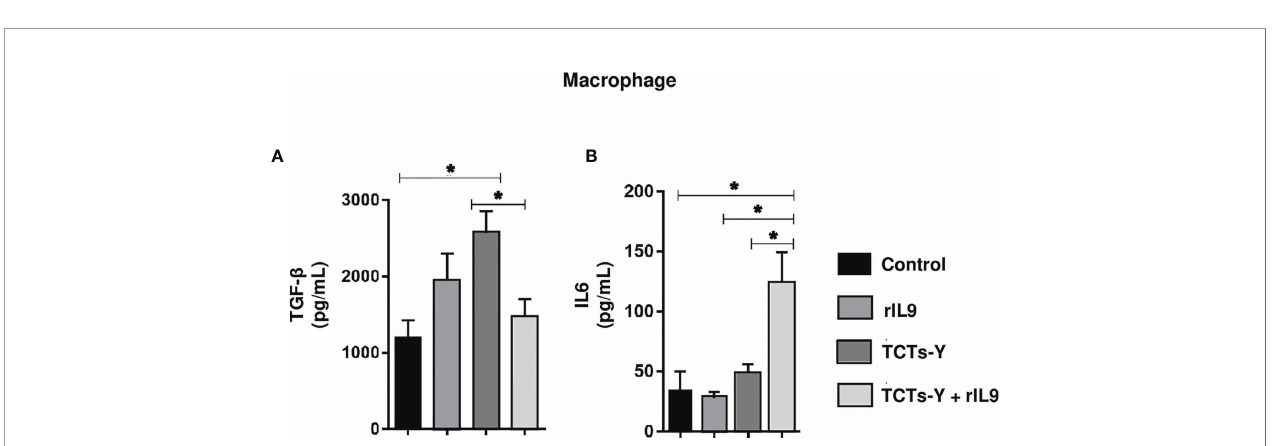
FIGURE 4 | Cytokine levelsin mediumfrominfected macrophages with and without rIL9treatment. Cellculture medium was collected at 72 hpi fromC2C12 cells and macrophages cultured with RPMI mediumonly, cells infectedand not treated,and cellsinfected and treated with rIL9. For infected macrophages, TGF- b secretion was lower with rIL9treatment (post-treatment) than without treatment (A) , and rIL9 treatment increased IL-6 levels comparedwith the other evaluatedgroups (B) . Anova test *p<